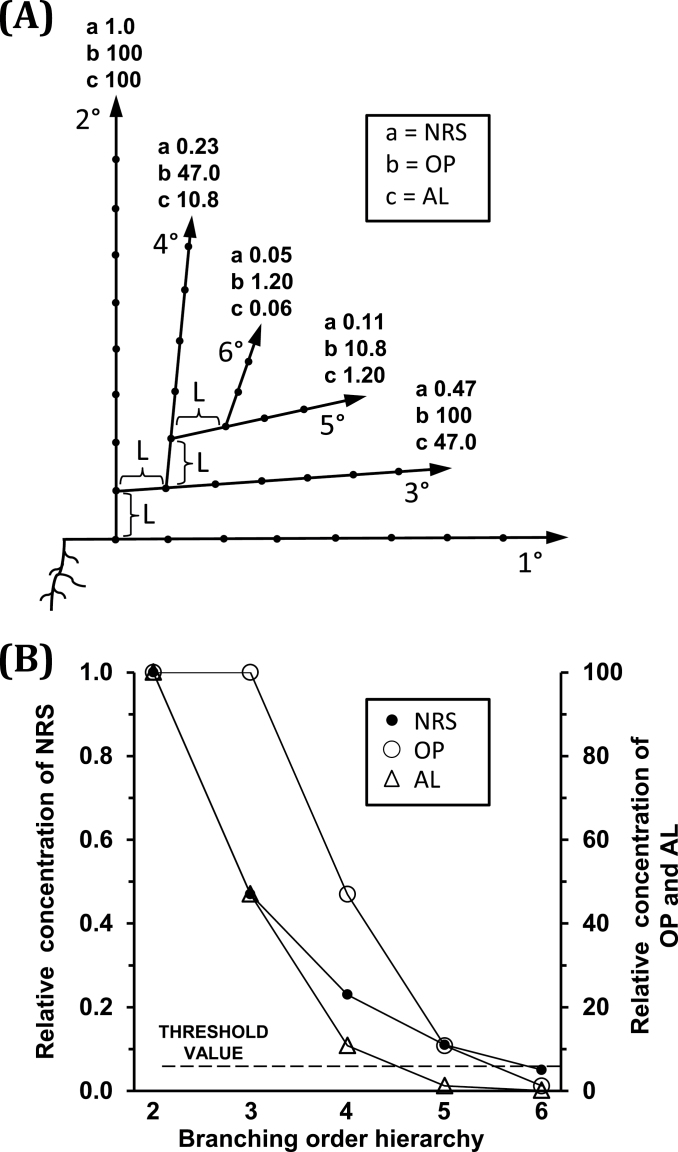
A diagrammatic representation (A) of the relative values for Trifolium repens of outgrowth potential (OP), net root stimulus (NRS), and activation level (AL) of the axillary bud at node position 1 on the primary stem (branching order 1) and for the axillary buds at the first node on each branch of the subsequent hierarchies of branching that could occur on a branch system developing at that node position (calculated where R=0.78 and L (delay in branch development) =2) with L indicated at each level of branching hierarchy; and (B) a plot of the values of OP, NRS, and AL showing the effect of OP in accelerating the reduction in AL as branching hierarchy increases so that AL is rapidly reduced below the threshold value of 6 (broken line) for branch outgrowth.